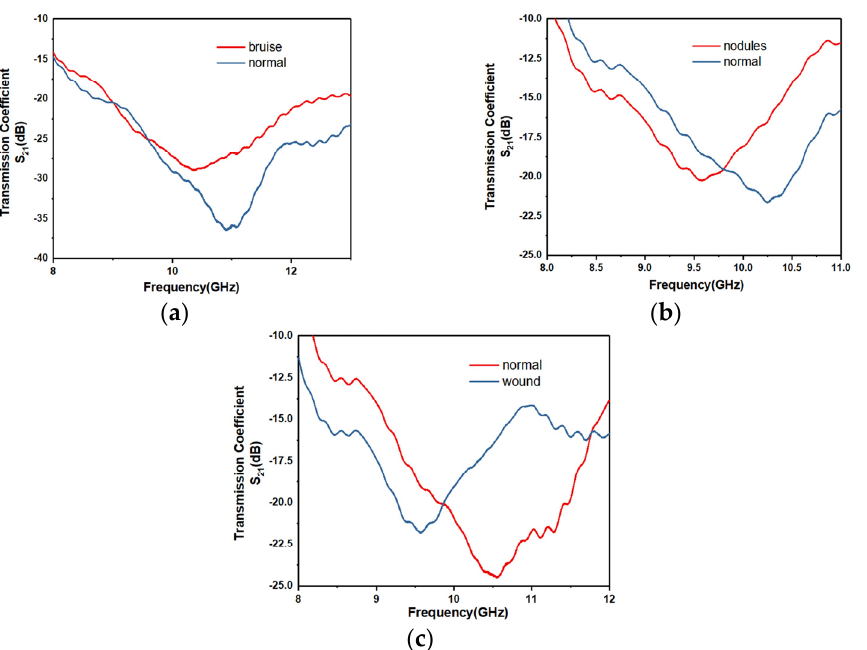
Figure 20. Measurement results with different abnormal skin abnormalities: ( a ) bruise; ( b ) nodules; ( c ) wound.